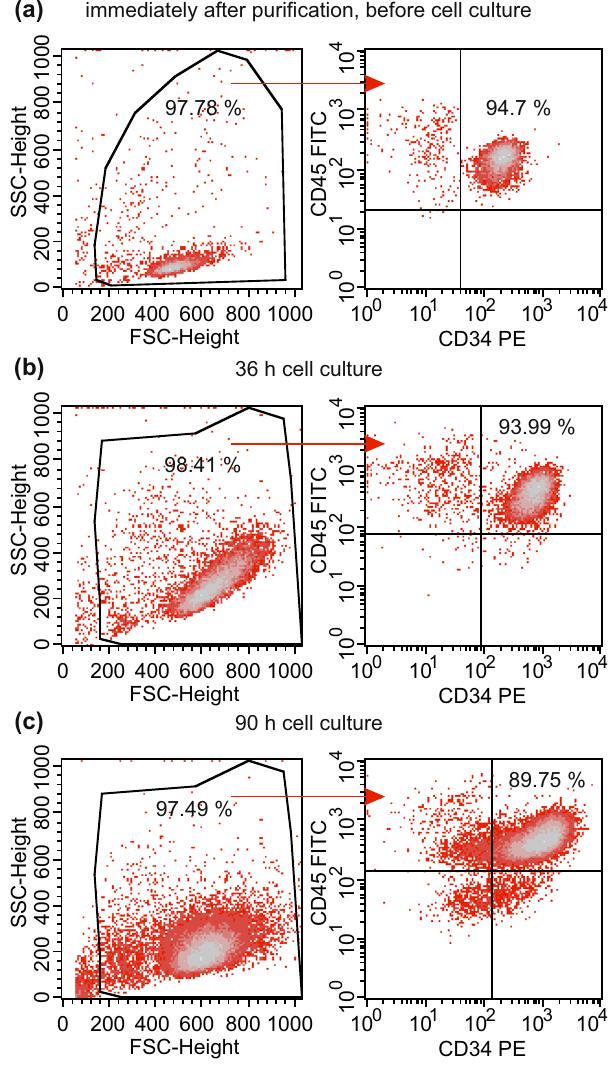
Figure 3. Fraction of CD34 + following selection using anti-CD34 MoAb coated immunomagnetic beads at time point 0 ( a ), after 36 h ( b ) and after 90 h of cell culture ( c ). Viable cells were gated using a forward scatter (FSC) vs side scatter (SSC) plot. The fraction of CD34 + cells was obtained in a CD34 vs CD45 plot based on all viable